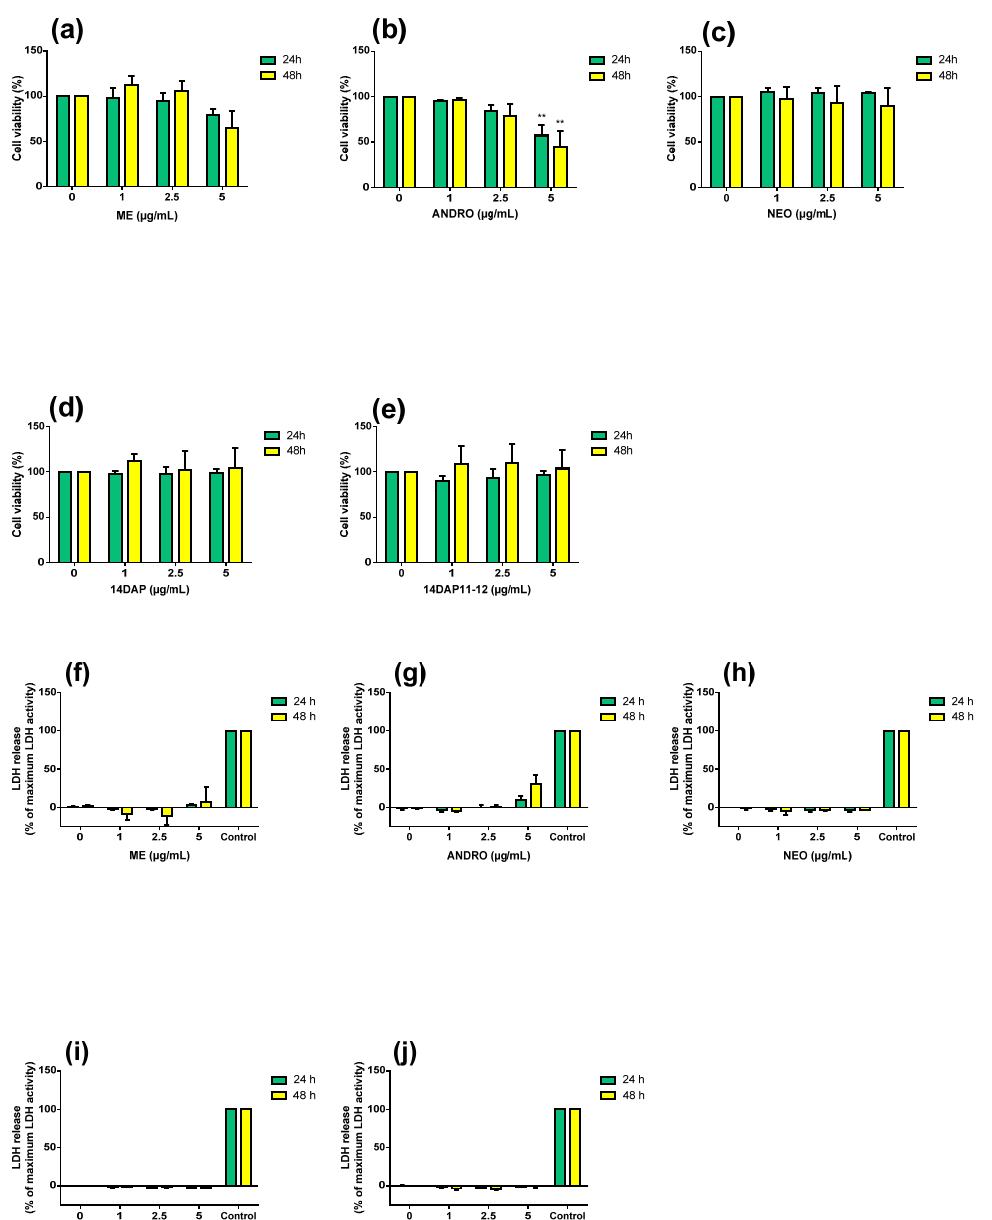
Figure 2. E ff ect of ME, ANDRO, NEO, 14DAP, and 14DAP11-12 on HaCaT cytotoxicity. HaCaT Figure 2. Effect of ME, ANDRO, NEO, 14DAP, and 14DAP11 ‐ 12 on HaCaT cytotoxicity. HaCaT was was treated with increasing concentrations (1, 2.5, or 5 µ g / mL) of ME ( a , f ), ANDRO ( b , g ), NEO treated with increasing concentrations (1, 2.5, or 5 μ g/mL) of ME ((a) and (f)), ANDRO ((b) and (g)), ( c , h ), 14DAP ( d , i ), or 14DAP11-12 ( e , j ) for 24 h and 48 h. The control cells were treated NEO ((c) and (h)), 14DAP ((d) and (i)), or 14DAP11 ‐ 12 ((e) and (j)) for 24 h and 48 h. The control cells were treated with 0.05% DMSO (noted as “0”). Cell viability was analyzed by mitochondrial with 0.05% DMSO (noted as “0”). Cell viability was analyzed by mitochondrial metabolism metabolism using an MTT assay ((a), (b), (c), (d), and (e)). Then, cell cytotoxicity was determined by using an MTT assay ( a – e ). Then, cell cytotoxicity was determined by a dosage of extracellular LDH activity ( f – j ). Cells untreated with stimuli were a negative control and cells treated with lysis agent were a positive control (noted as “Control”). The values are mean ± SD, ** p < 0.01 compared with control group, n = 3. Abbreviations: NEO, neoandrographolide; 14DAP, 14-deoxyandrographolide; 14DAP11-12, 14-deoxy-11,12-didehydroandrographolide; DMSO, dimethyl sulfoxide; MTT, 3-(4,5-dimethylthiazol-2-yl)-2,5-diphenyltetrazolium bromide; LDH, lactate